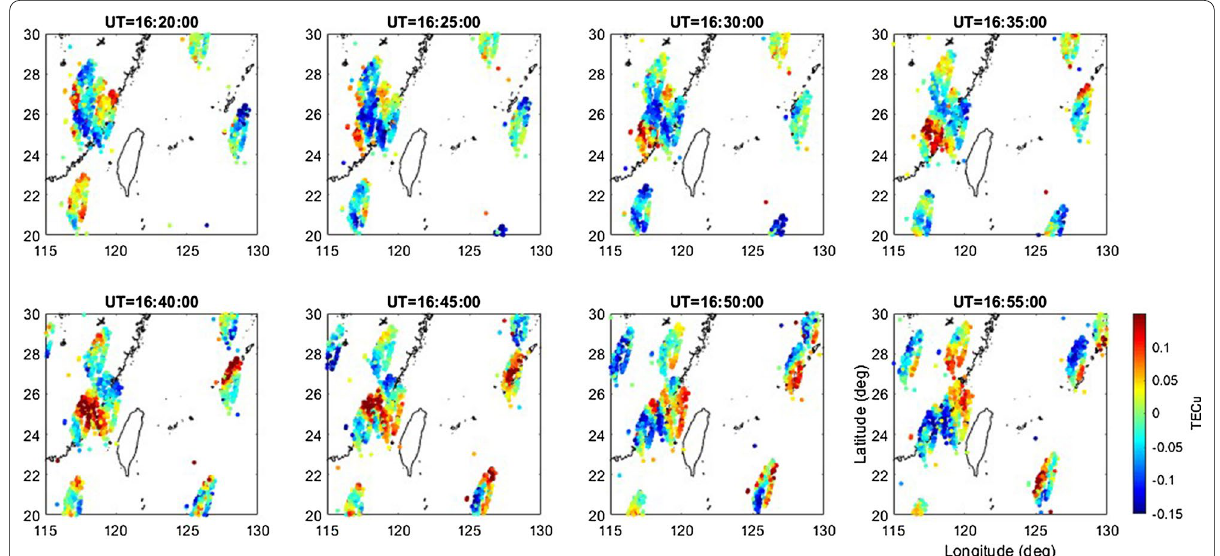
Fig. 9 Two‑dimensional filtered GNSS‑TEC maps over Taiwan on 29 April